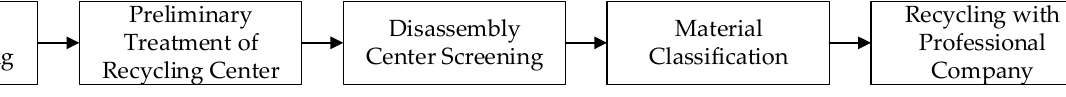
Figure 3. Battery recycling process.